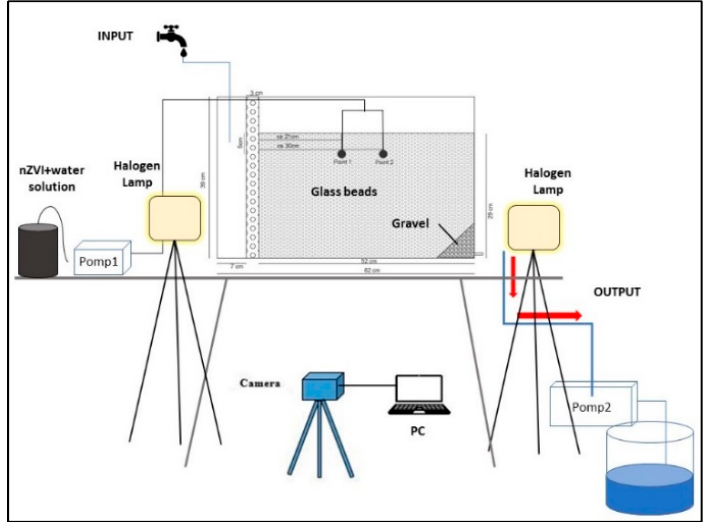
Figure 1. Experimental apparatus.